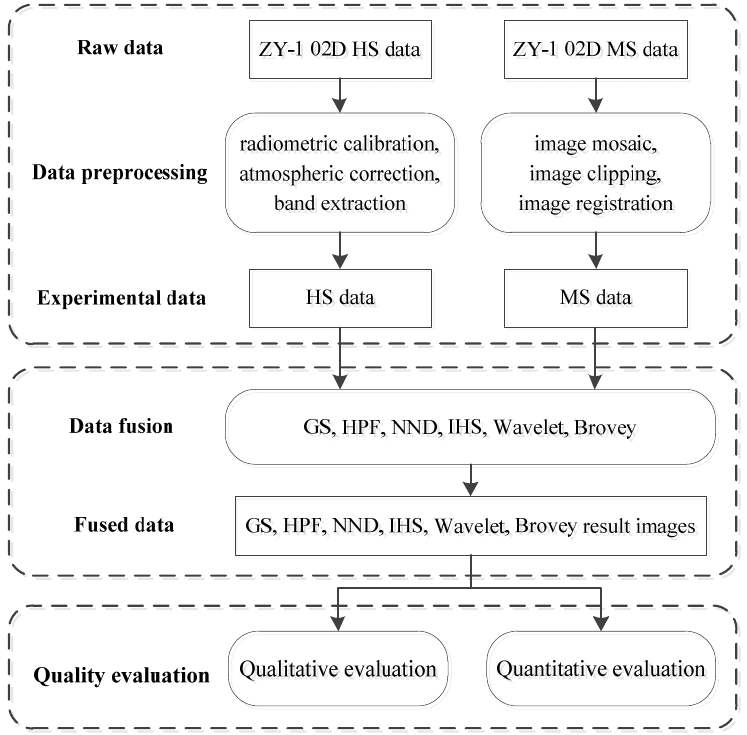
Figure 3. Methodological flowchart of the research. GS: Gram-Schmidt; HPF: High-Pass Filter; NND: Nearest-Neighbor Diffusion; IHS: Intensity-Hue-Saturation; Wavelet: Wavelet Transform; Brovey: Color Normalized Sharping.